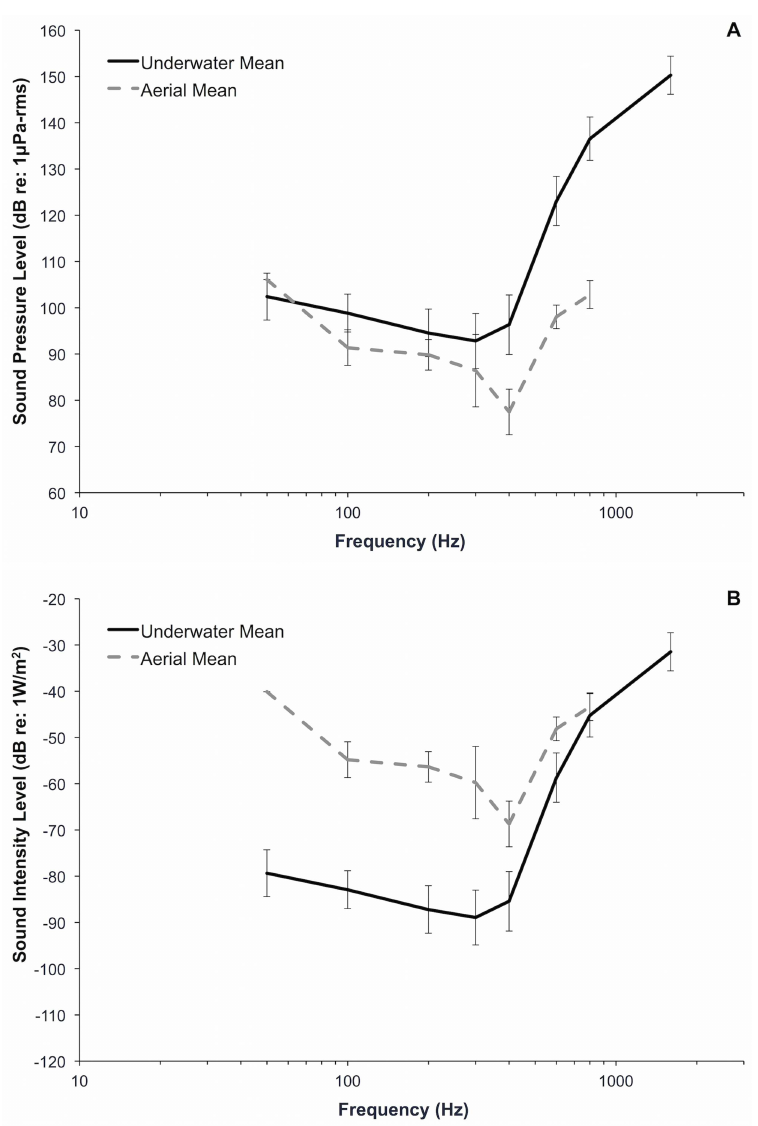
Fig 6. Comparison of mean ( ± 1 SD) underwater and aerial audiograms for juvenile green sea turtles ( Chelonia mydas ) in terms of pressure (A) and intensity (B).